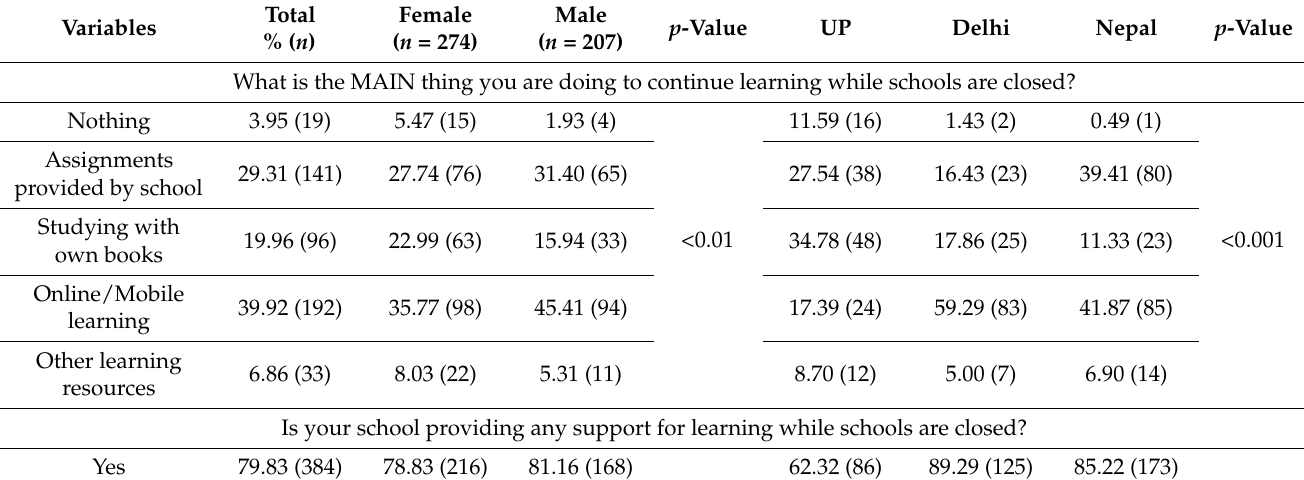
Table 4. Experiences with School Closures During